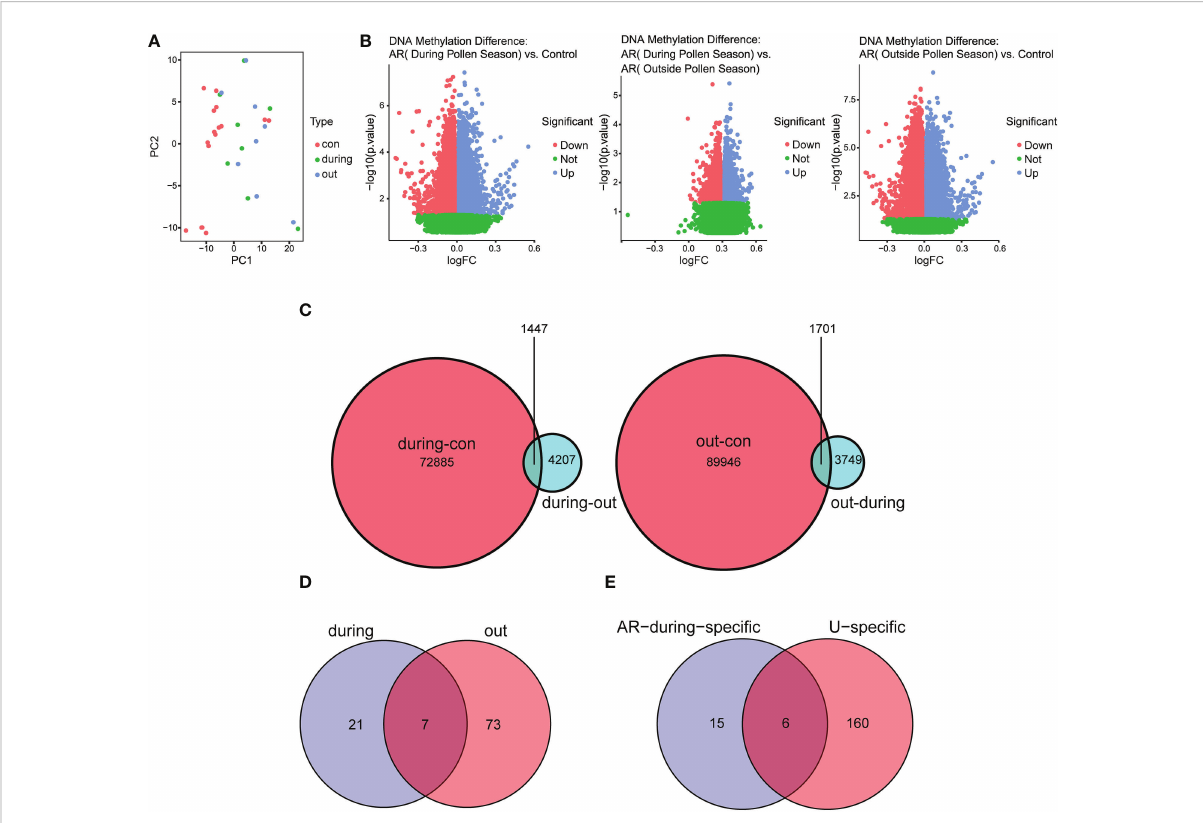
FIGURE 6 Identi fi cation of DMPs in CD4+ T cells from AR and CSU patients. (A) The PCA plot of patients with AR during or outside pollen season and normal control samples. (B) The volcano plot of pollen season related DMPs in AR patients and normal control samples. (C) The Venn diagram showed pollen-related and pollen-independent DMPs. (D) The Venn diagram showed the number of regulatory pathways of AR genes during or outside the pollen season. (E) The Venn diagram showed the number of common signaling pathways regulating AR and CSU during the pollen season. DMPs, differentially methylated CpG